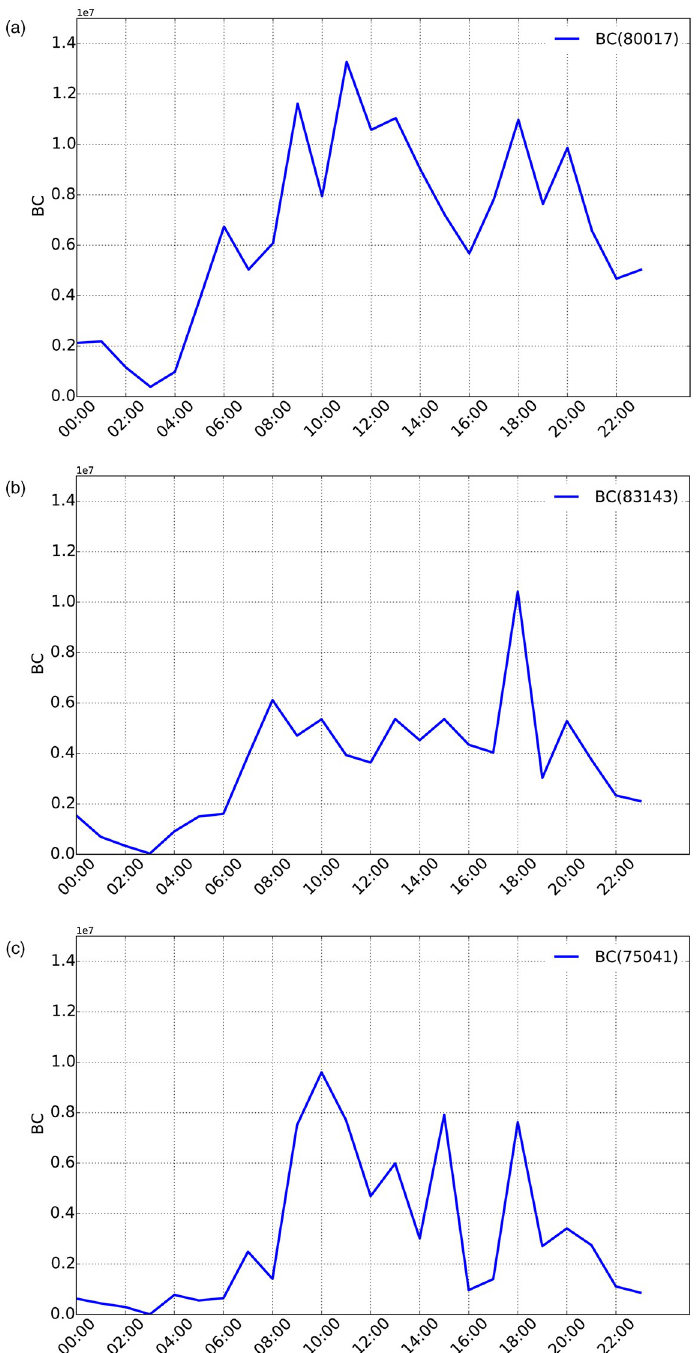
Fig 6. Evolution over time of the top-BC node for some time slots of the dynamic taxi graph. (a) Node with the highest BC at 06:00: evolution of its BC over time (b) Node with the highest BC at 08:00: evolution of its BC value over time (c) Node with the highest BC at 10:00: evolution of its BC value over time.